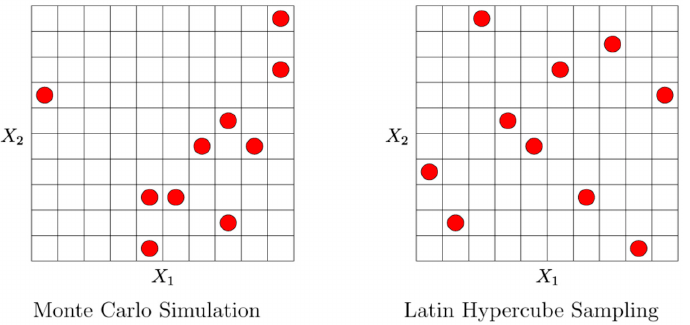
Figure 9. Monte-Carlo method vs. Latin Hypercube Sampling in 2D.